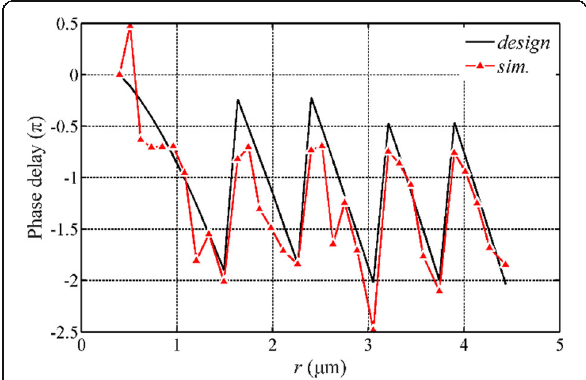
Fig. 10 Phase analysis of the NRPL under the radially polarized incident light